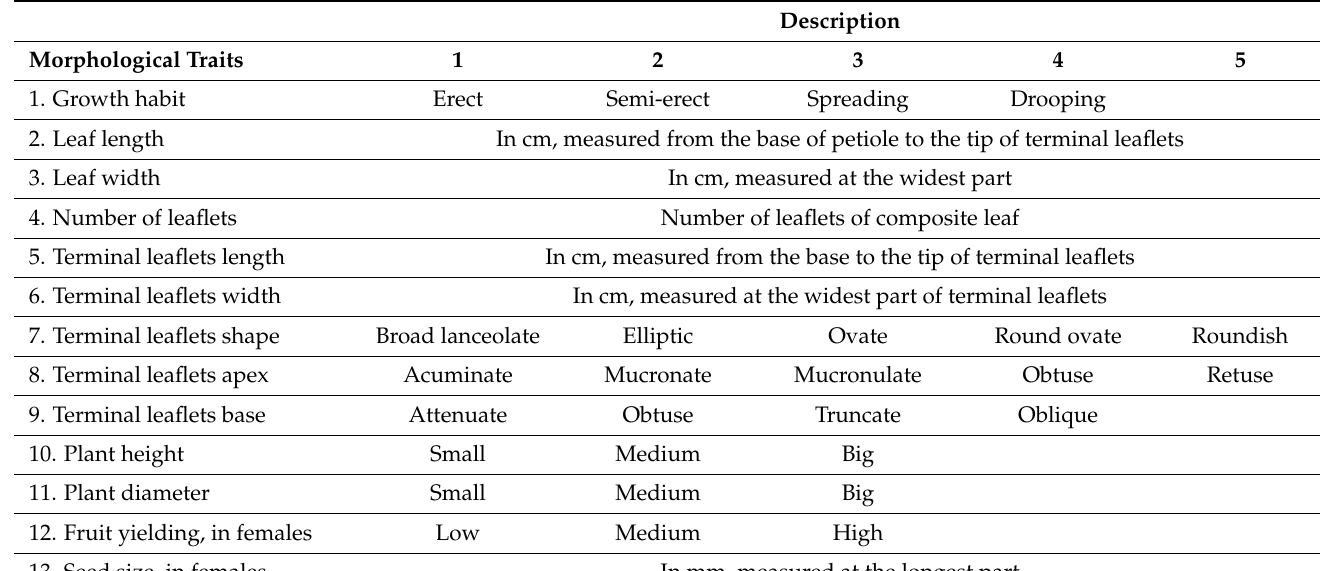
Table 2. Morphological traits presentation for the 20 selected genotypes of P. lentiscus var. Chia focusing on properties related mainly to the appearance of the trees and their ornamental value.